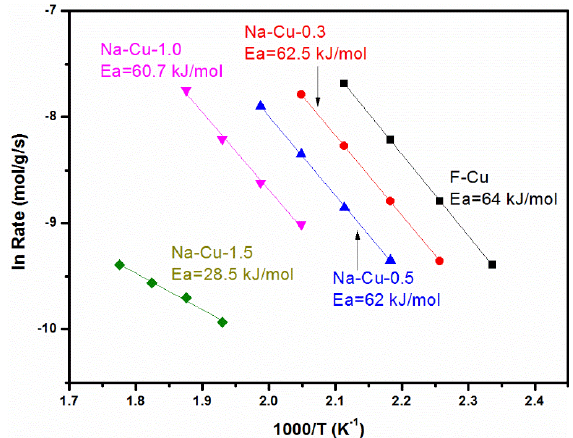
Figure 9. Arrhenius plots of the SCR reaction rates over fresh and Na-impregnated catalysts. The reaction was carried out with a feed containing 500 ppm NO x , 500 ppm NH 3 , 10% O 2 , 3% H 2 O, balance N 2 , and with GHSV = 316,800 h −1 .